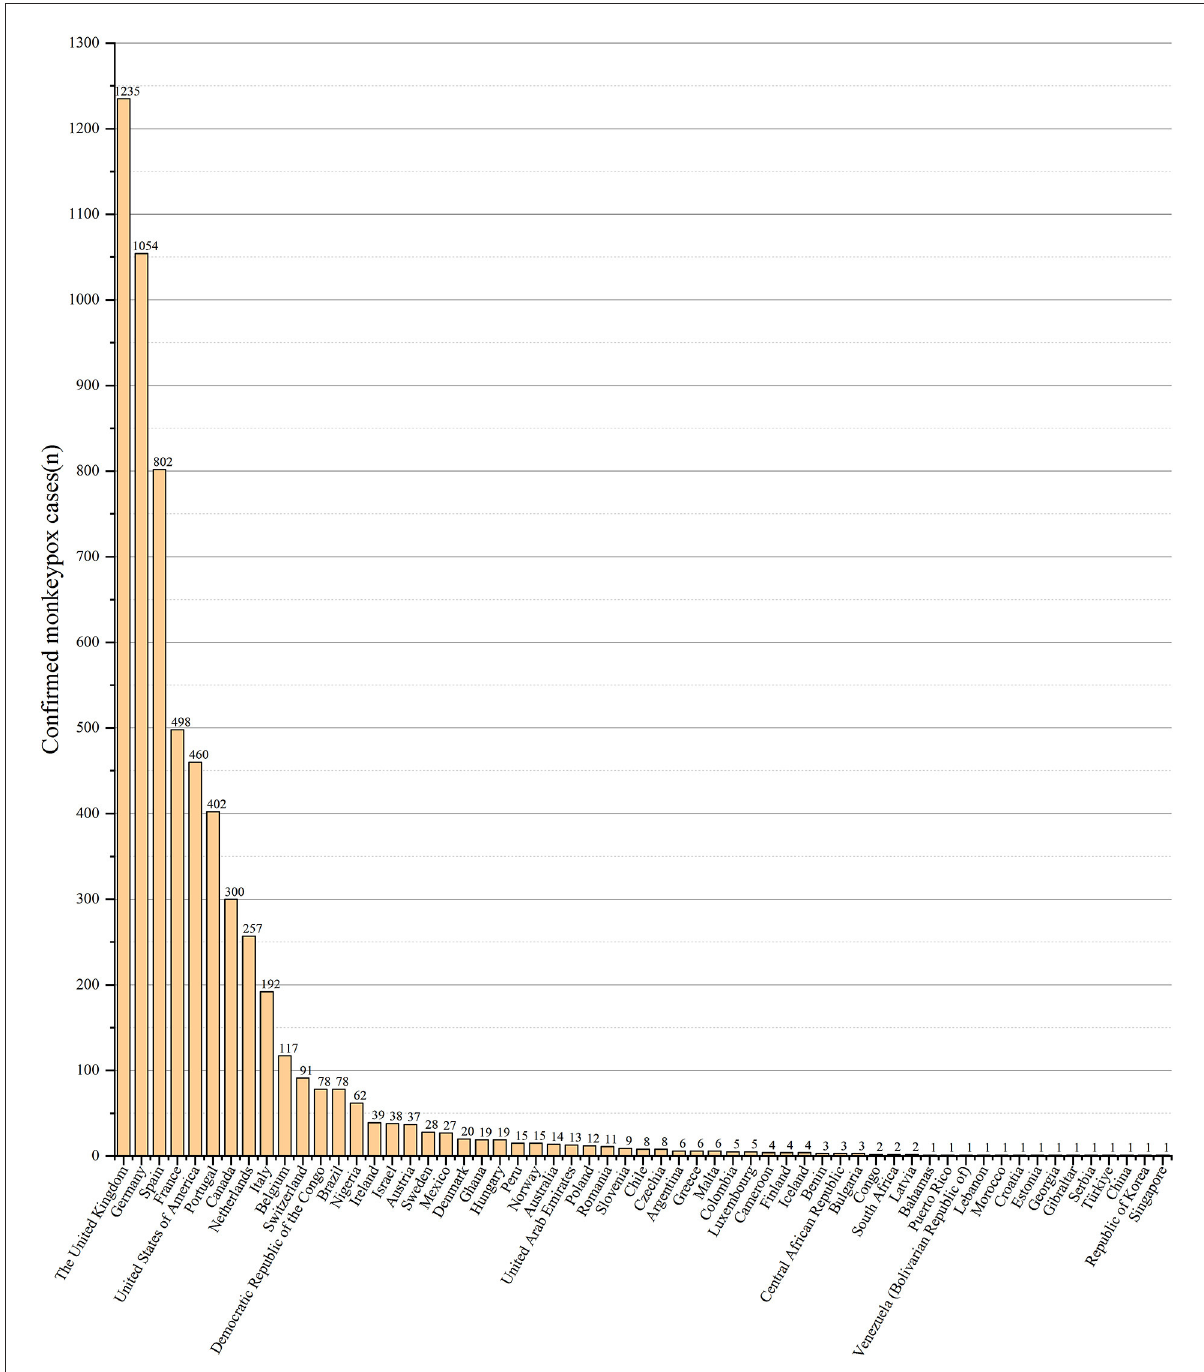
FIGURE12 Confirmed human monkeypox cases reported by regions/countries from January 1 to July 1, 2022. The data were derived from World Health Organization